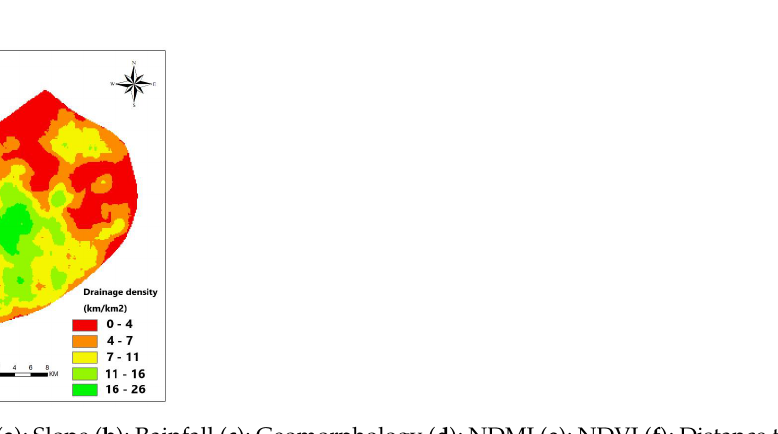
Figure 3. Altitude ( a ); Slope ( b ); Rainfall ( c ); Geomorphology ( d ); NDMI ( e ); NDVI ( f ); Distance to waterbodies ( g ); LULC ( h ); Drainage density ( i ).